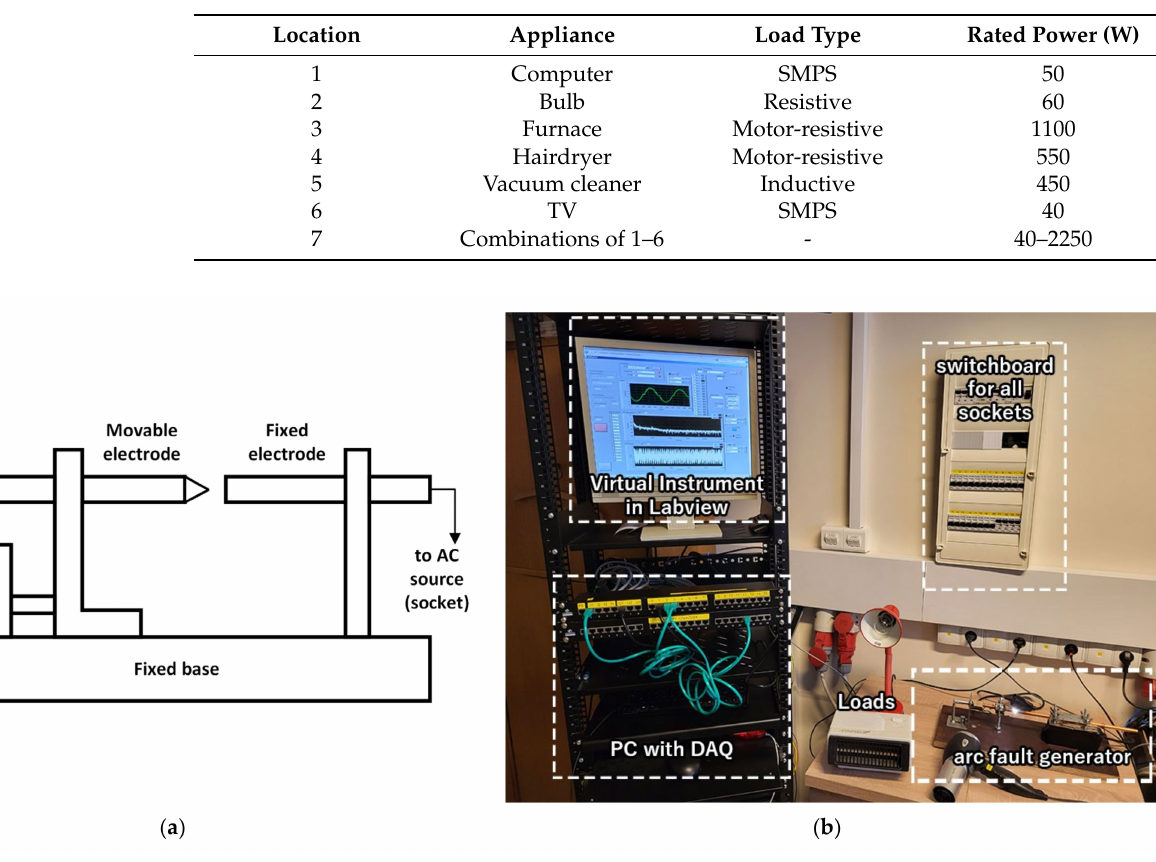
Figure 4. ( a ) Schematic setup of series arc fault generator and ( b ) photo of experimental equipment. In every run, signals u total and i total were registered. At the third channel of DAQ card, the signal representing i j was recorded (where j was the socket number with the arc fault generator connected). These data were used for manual labeling feature vectors